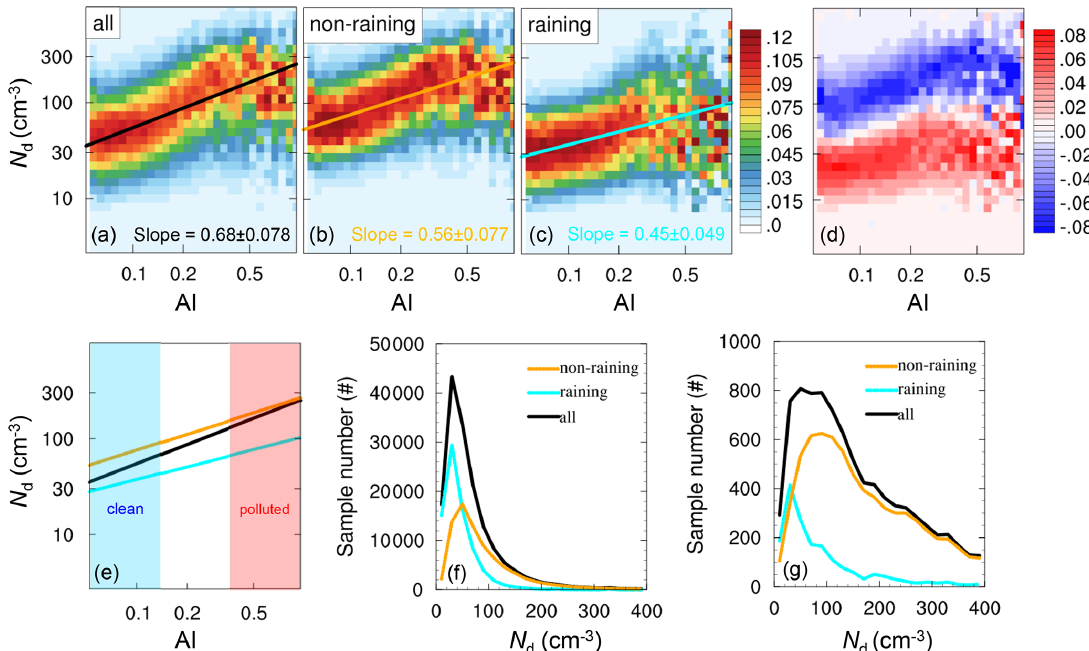
Figure 4. Joint histograms between AI and N d created for (a) all clouds, (b) non-raining, and (c) raining clouds, as well as (d) the difference of joint histograms between the raining and non-raining cases. Cloud susceptibilities to AI derived via the pre-binned approach are also shown along with 95% uncertainty estimates (according to a Student’s t test). The fitting lines for three cases are merged into one single plot (e) , with clean and polluted zones marked as blue and red, and the corresponding sample distributions are also shown (f, g)